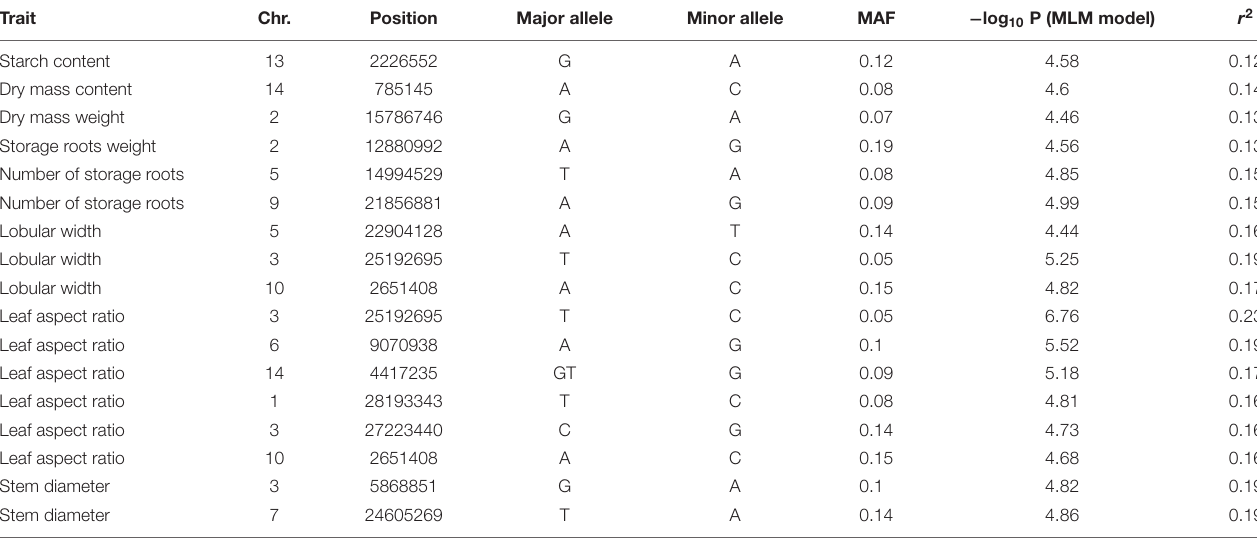
TABLE 2 | Genome-wide significant association signals of 11 agronomic traits from the compressed mixed linear model (MLM). Trait